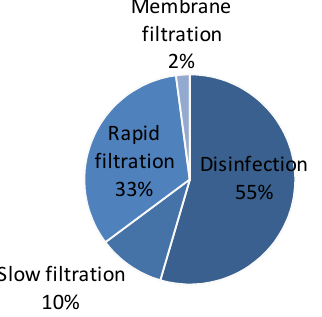
Figure 5. Adoption ratio of treatment processes for waterworks in Japan.